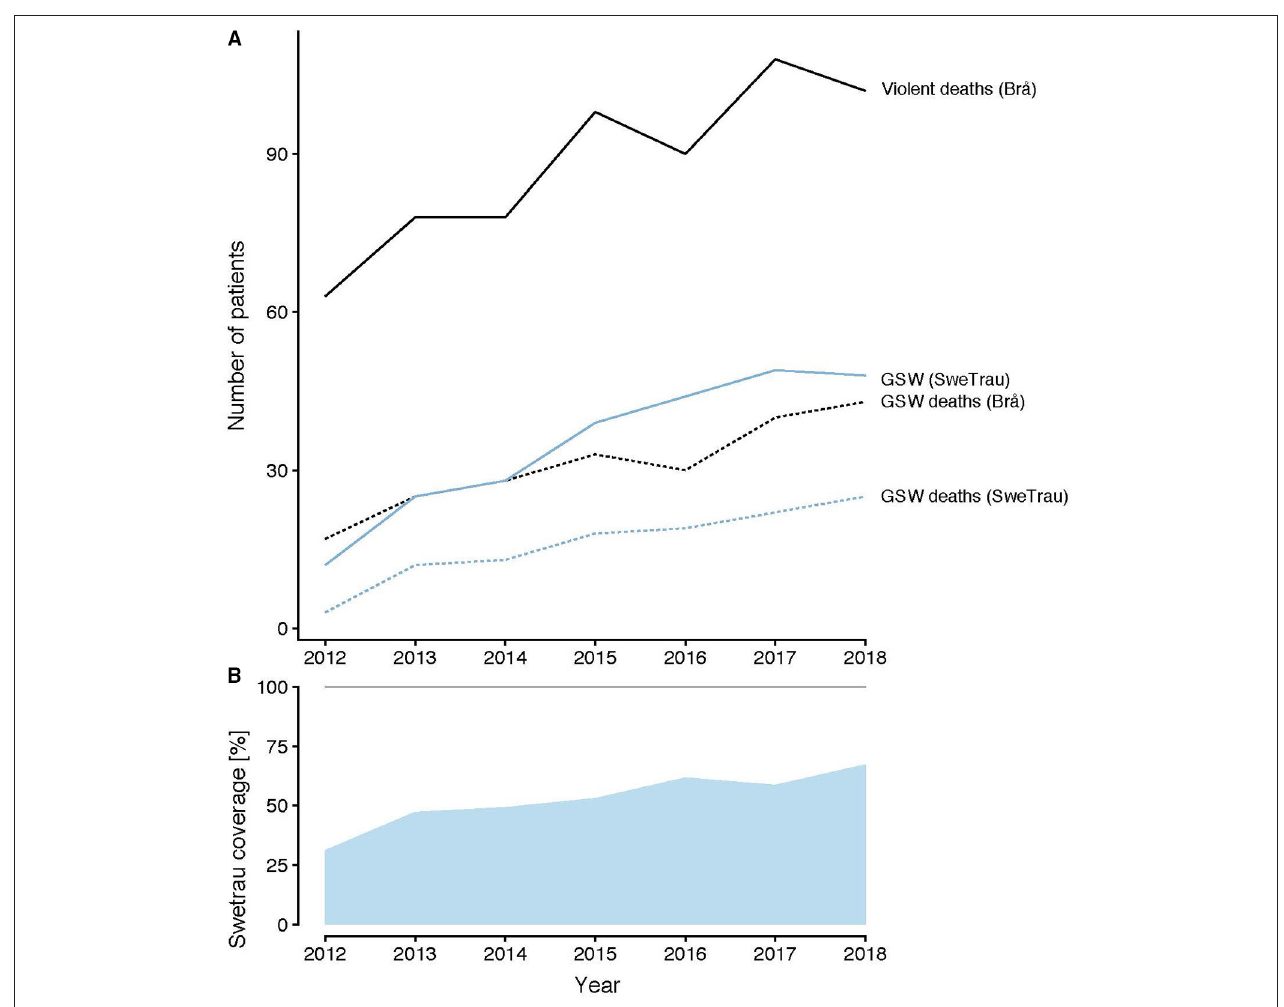
FIGURE 3 | (A) Cases of violent deaths (black) and GSW deaths (black dotted), statistics from Brå. Cases of GSW from SweTrau (blue) and GSW deaths (blue dotted) from SweTrau. (B) SweTrau coverage [the number of patients with a trauma diagnosis and intensive care needs in SweTrau divided by the number of care sessions in the Swedish Intensive Care Registry (SIR)]. GSW, gunshot